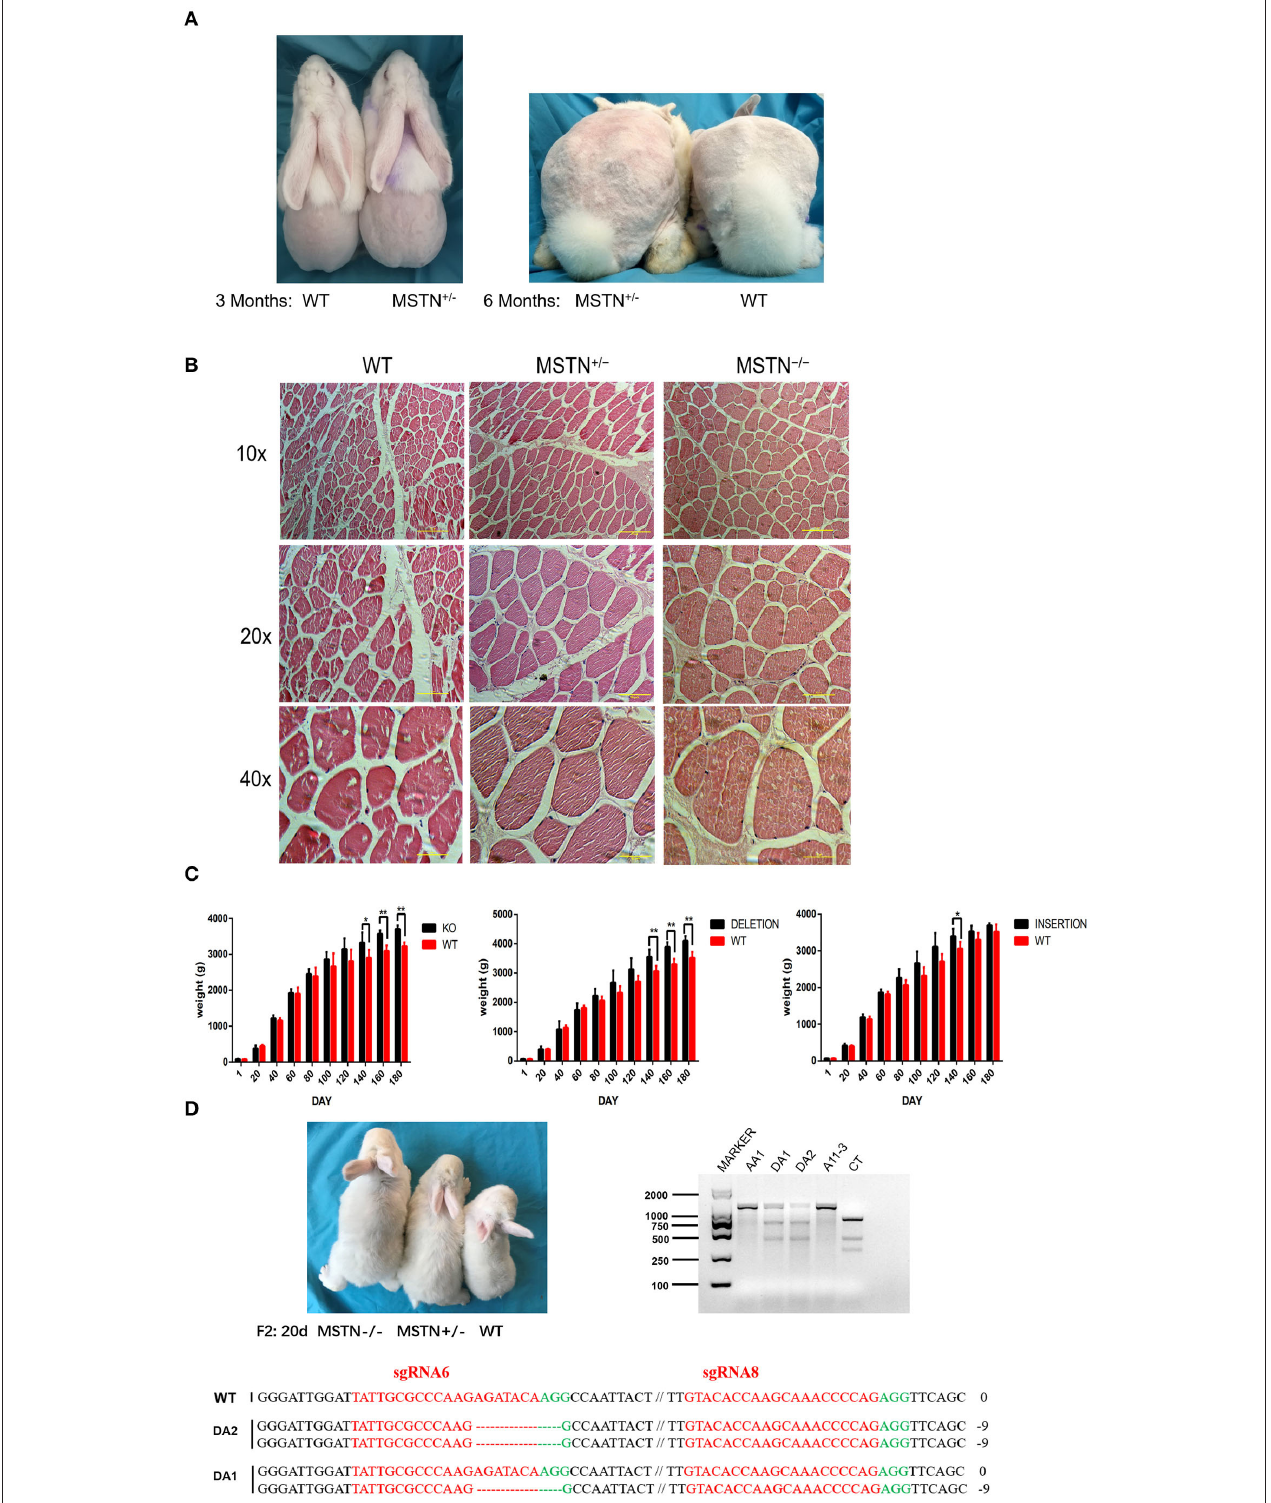
FIGURE 7 | Detection and observation of MSTN -KO rabbits. (A) Comparison of mediated and wild-type rabbits at 3 and 6 months of age. (B) The average body weight of MSTN + / − and WT rabbits from F0 and F1 ( n = 5), and the left side shows the weight gain of F0 knockout rabbits and wild rabbits, the middle shows the weight gain of F1 deletion editing rabbits and wild rabbits, and the right side shows the weight gain of F1 insertion editing rabbits and wild rabbits. (C) HandE staining of the muscle fibers from gluteus maximus . (D) Shape difference map and identification results of F2 generation rabbits at the age of 20 days (The picture has been